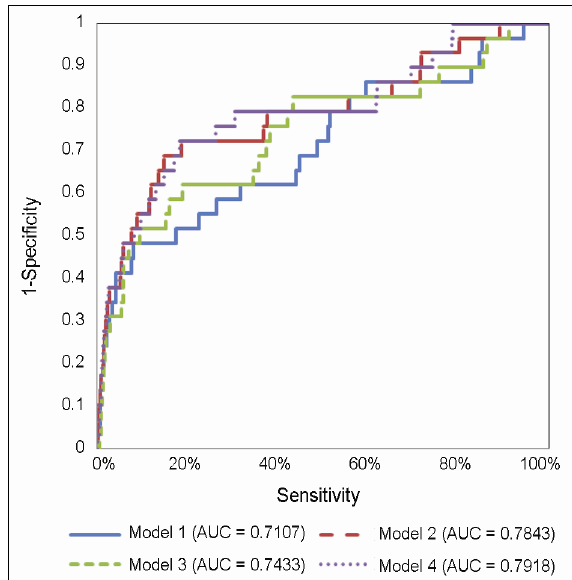
Fig. 1. ROC curves for multivariate Logit models on prior one-year